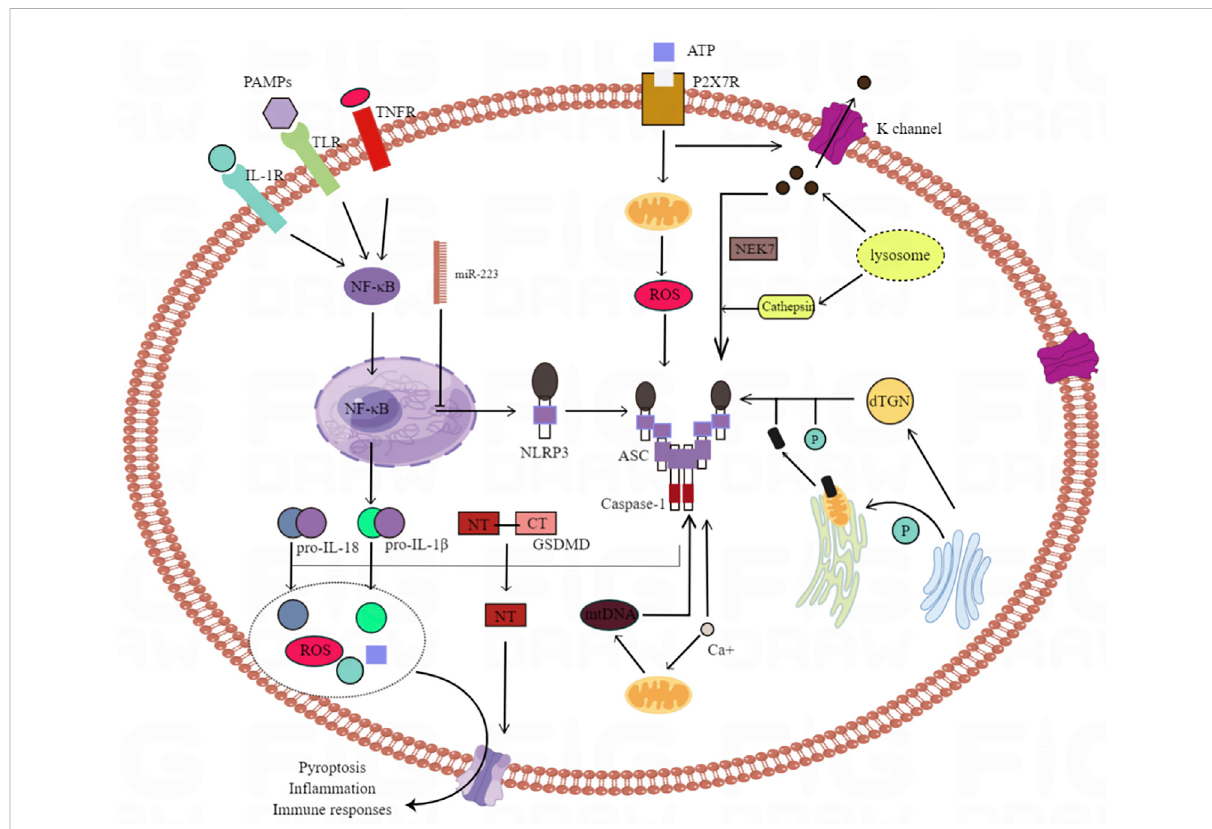
FIGURE 4 The mechanisms underlying NLRP3 in fl ammasome activation. There are many trigger factors for the activation of NLRP3 in fl ammatory bodies, including K + ef fl ux, Ca 2+ mobilization, endoplasmic reticulum stress, lysosomal leakage and mitochondrial dysfunction. NLRP3 activation is also triggered by several mechanisms involved in Golgi vesicle transport of the Golgi apparatus and endoplasmic reticulum. Dispersed TGN (trans Golgi network) provides a scaffold for the formation of NLRP3 lacrimal dots, and promotes the assembly and activation of NLRP3 in fl ammatory bodies; PtdIns4P as the binding site. Activation of NLRP3 in fl ammatory bodies can induce GSDMD (gasdermin D) and pre IL - 1 β And pre IL - 18. NT- GSDMD (N terminal - GSDMD) forms a hole on the cell membrane to induce the pyrolysis and release of intracellular